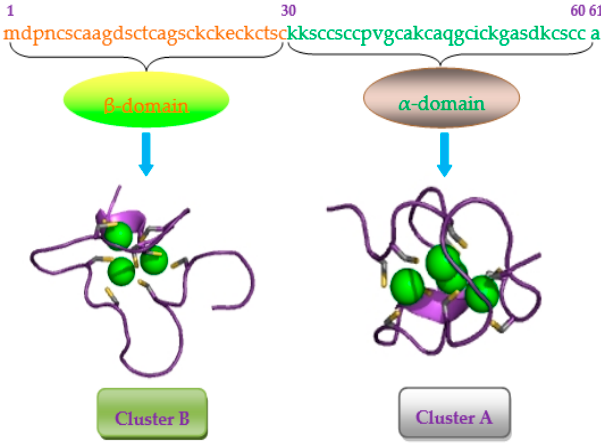
Figure 1. Structure of human metallothionein-2 (MT-2). Amino acid sequence and 3D structure were retrieved from UniProt (P02795). Class I MT2 contains 2 metal-binding domains: four divalent ions are chelated within cluster A of the α -domain and are coordinated via cysteinyl thiolate bridges to 11 cysteine ligands. Cluster B , the corresponding region within the β -domain, can ligate three divalent ions to 9 cysteines. The 3D structures show that cluster A could bind three metal ions (Cd 2+ ), and cluster B could bind four metal ions (Cd 2+ ), respectively.